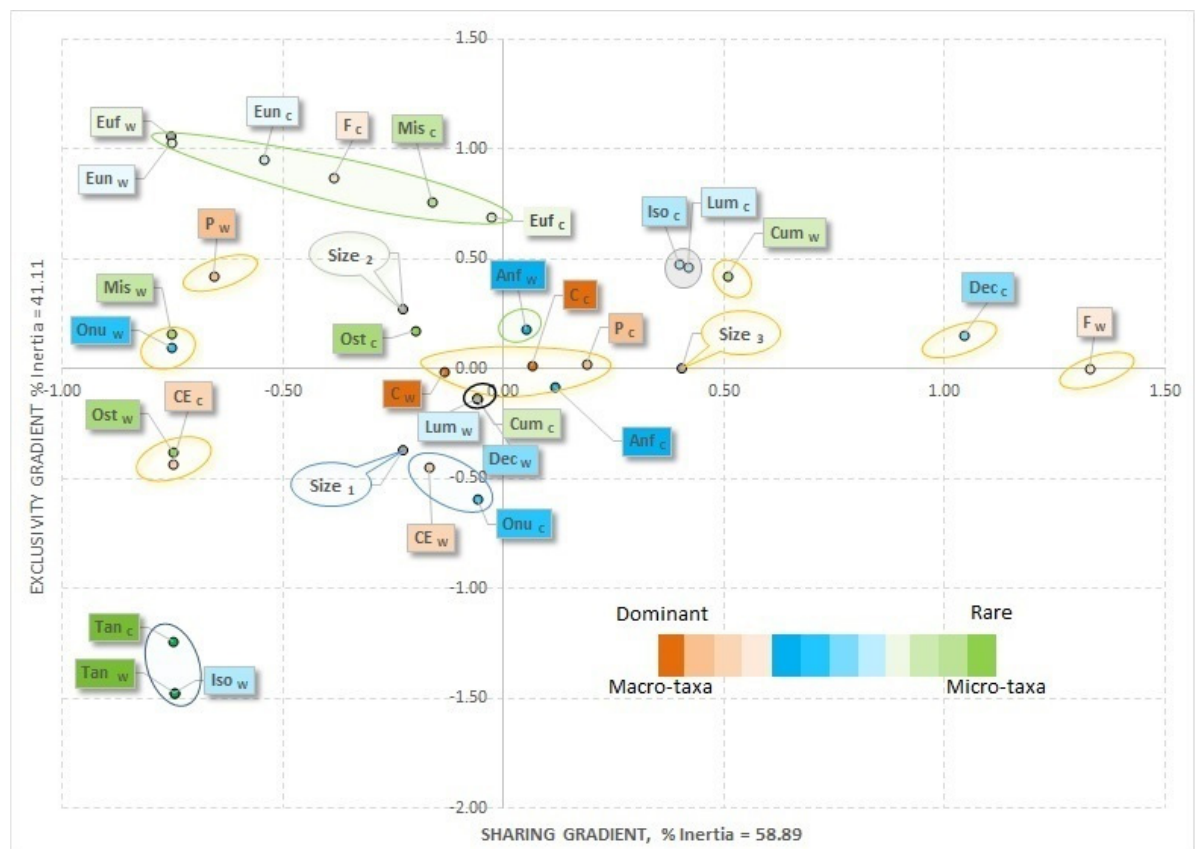
Figure 6. Biplot from correspondence analysis representing the two main gradients of variation in the diet of Coelorinchus caelorhincus based on prey importance index of prey identified at the macro-taxa level (F: Fish; C: Crustaceans; P: Polychaetes; CE: Cephalopods) and the micro-taxa level (Anf: Amphipods; Iso: Isopods; Mis: Mysids; Dec: Decapods; Tan: Tanaids; Ost: Ostracods; Euf: Euphausids; Cum: Cumaceabs; Onu: Onuphids; Eun: Eunicids; Lum: Lumbrinerids) in the stomachs of sample of Coelorinchus caelorhincus from Central Thyrrhenian sea. ‘W’ and ‘C’ subscripts stand for the warm and cold periods, respectively. Same background colors denote same prey category. Shadowed circled areas represent groups of prey more associated to sharing gradient (light yellow) or to exclusivity gradient (light blue for size 1 and light green for size 2 ). Not-encircled prey represent borderline categories between gradients and transparent dark circled area encloses prey who had null values along all predator size classes in a given period. Sizes ( 1 , 2 , 3 ) are for smallest (20–35 mm), intermediate (35–50 mm), and largest size classes (50–86 mm), respectively. Sharing is intended as the status of a prey for which predators exhibit intra-specific contest competition such that a monotonic trend of prey importance is expected along size classes. Exclusivity is intended as the prevalence of a given prey by a given period in a particular size class of the